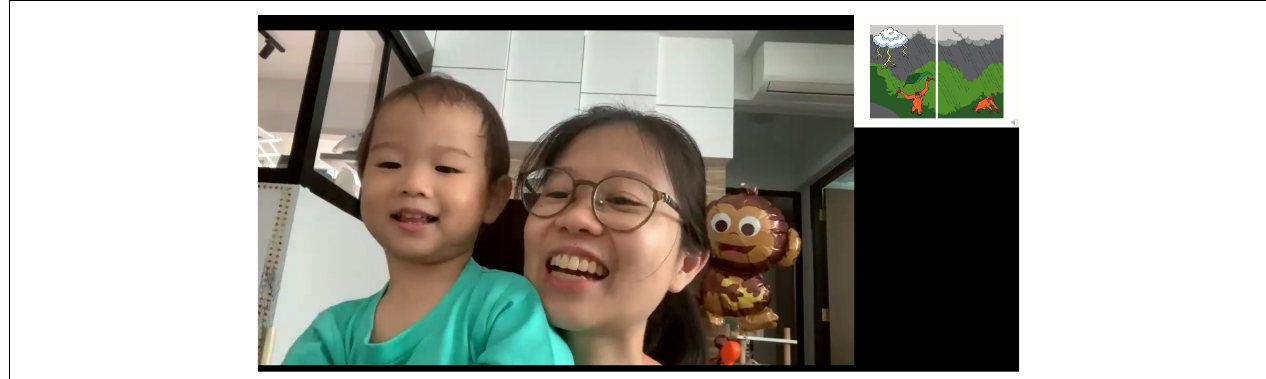
FIGURE 2 | Illustration of the Videocall Storytime procedure for recording parent-child interactions. Left: zoom-captured image of a parent describing the onscreen wordless picture book. Right: onscreen images from the little orangutan book “What a Scary Storm!” image reproduced with permission (Yogarrajah et al., 2021).